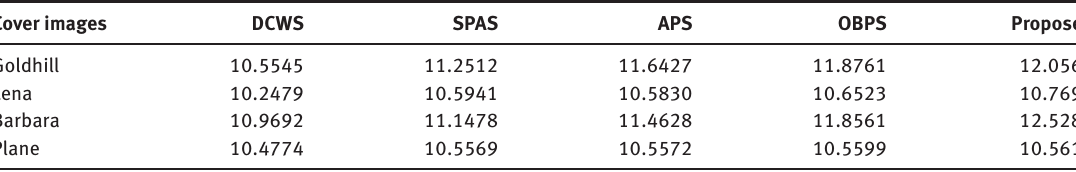
Table 3: PSNR Values of Extracted Cameraman.